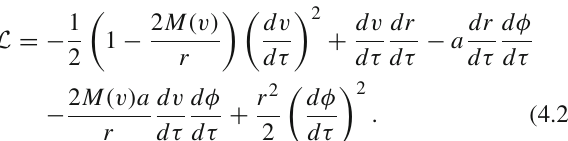
Fig. 1 The evolution of the ISCO in the Vaidya spacetime